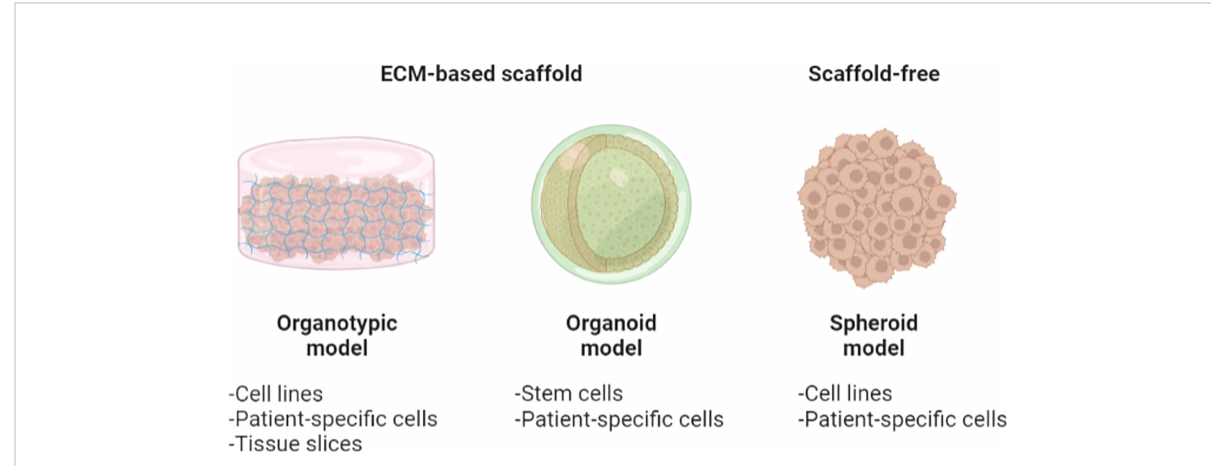
FIGURE 5 An illustration of organotypic culture models. Organotypic models provide cell – cell/ECM interactions within the culture model. Organotypic models are 3D in vitro platforms comprising the embedment of disaggregated cells/tissues in ECM-based scaffolds. Particularly, organoids are those organotypic models derived speci fi cally from stem or patient-speci fi c cells. Spheroids may be fabricated using one or multiple conventional cell lines or patient-derived cells, with or without the use of ECM-based embedment. Figure created with BioRender.com.